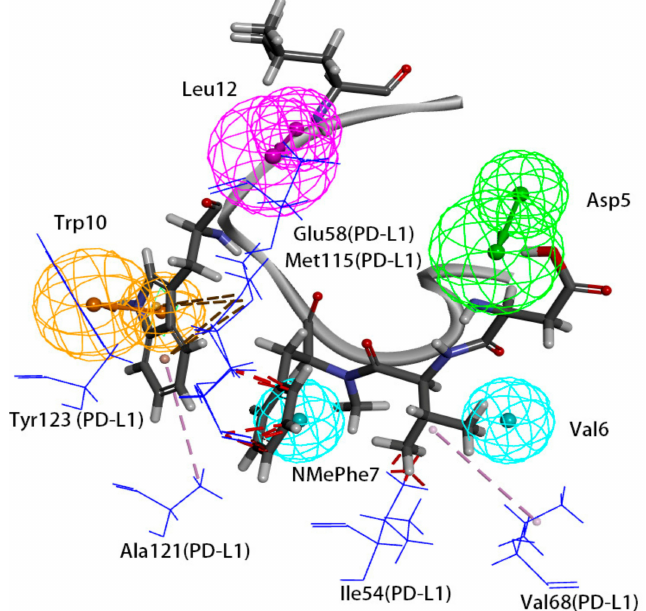
Figure 7. Superposition between Hypo 1A and peptide-71. As the figure shows, the hydrophobic point is blue, the hydrogen bond donor is purple, the hydrogen bond acceptor is green, and the aromatic ring point is orange. The interacted residues of PD-L1 are blue.